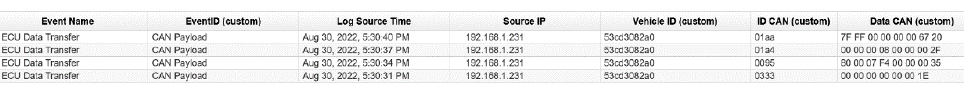
Figure 6. Messages generated by ICSim and transformed into JSON format by the TCU component. Figure 7. Result after creating all properties. On console it can be seen the correctly formatted payload.